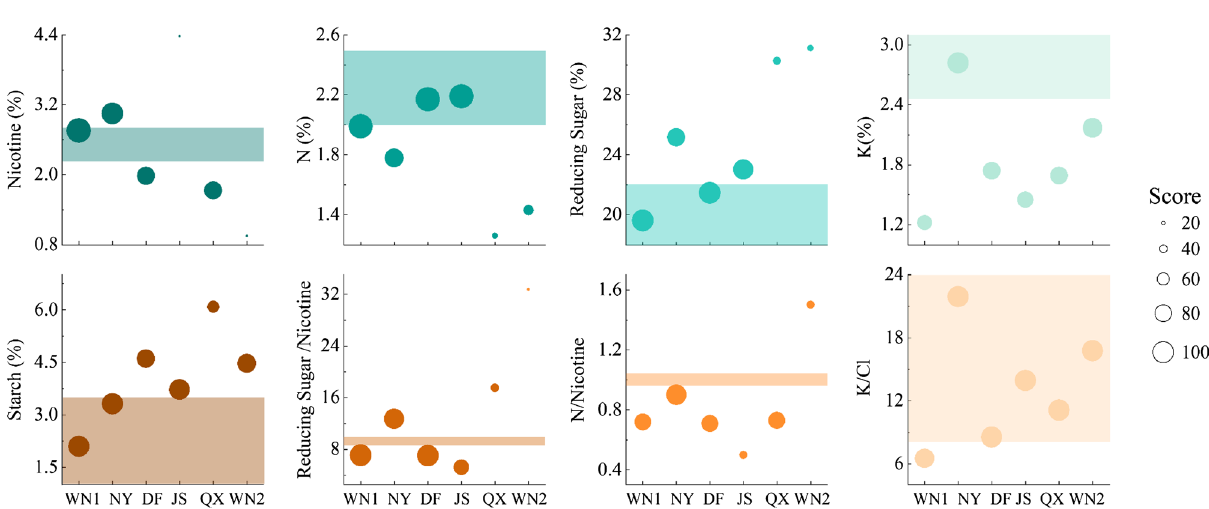
Figure 2. The chemical composition of tobacco leaves and their corresponding score based on the evaluation system. The size of the bubble represents the score of each index. The background filled with color on the graph is the area with a perfect